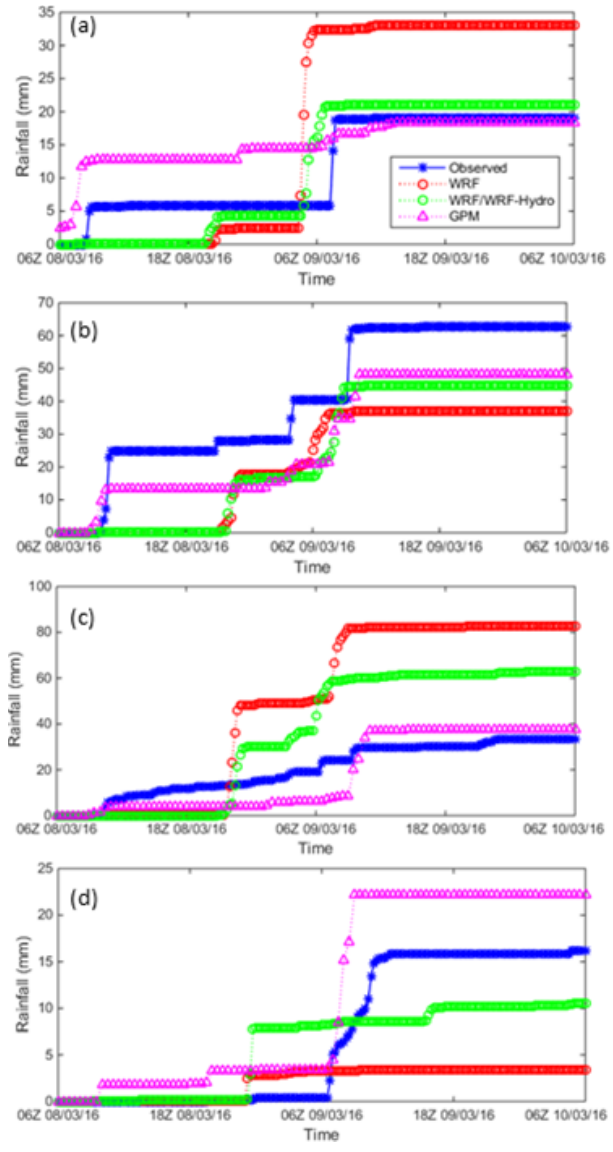
Figure 4. Comparison of accumulated rainfall at Abu Dhabi (a) , Al Ain (b) , Jabal Hafeet (c) , and Jabal Mebreh (d) from stations with WRF, WRF–WRF-Hydro simulations, and GPM